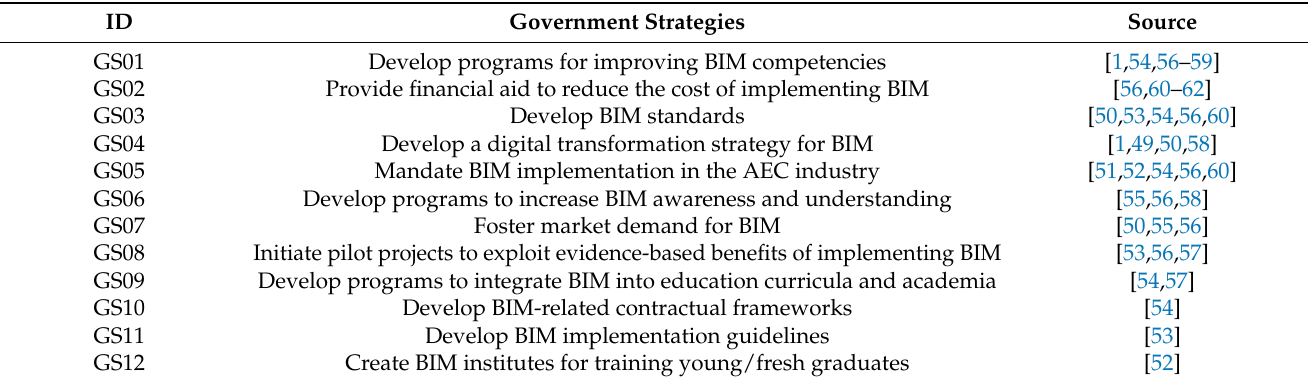
Table 1. Government strategies to enhance BIM